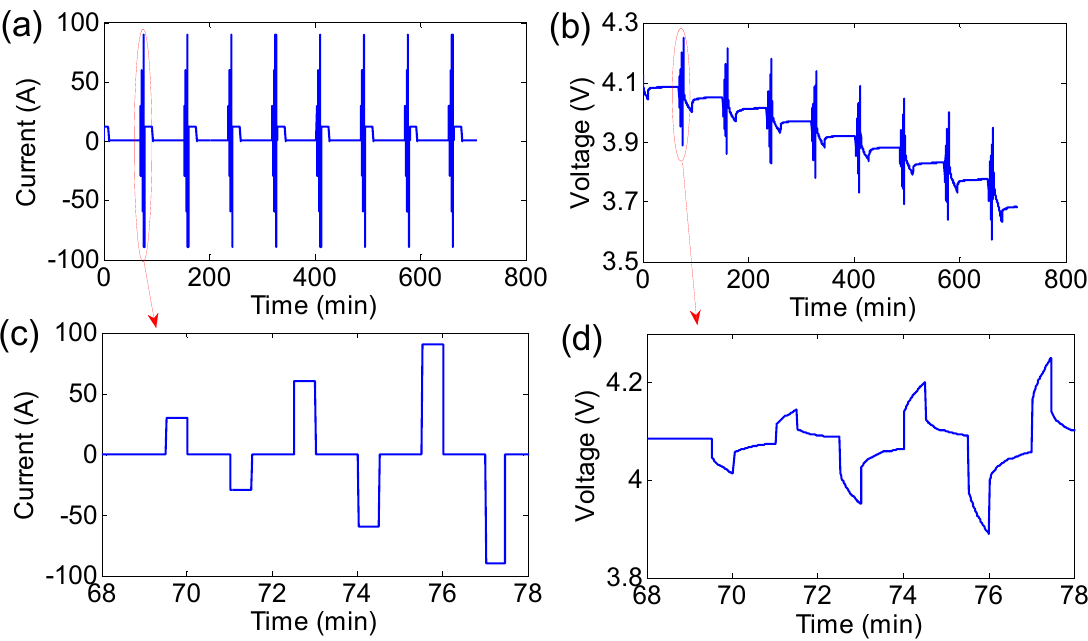
Figure 5. Hybrid pulse test. ( a ) Current demand; ( b ) Corresponding voltage; ( c ) Current pulses at SoC 90%; ( d ) Voltage of current pulse at SoC